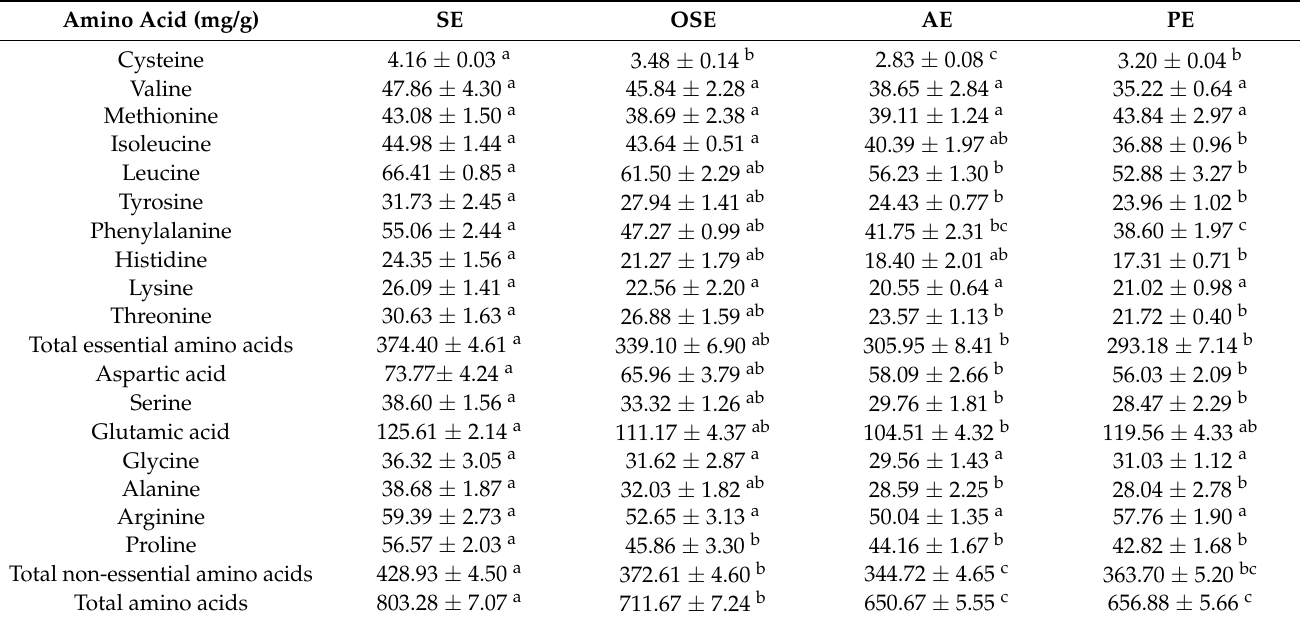
Table 2. Amino acid composition of field muskmelon seeds protein extracted by different oil extrac- tion methods.